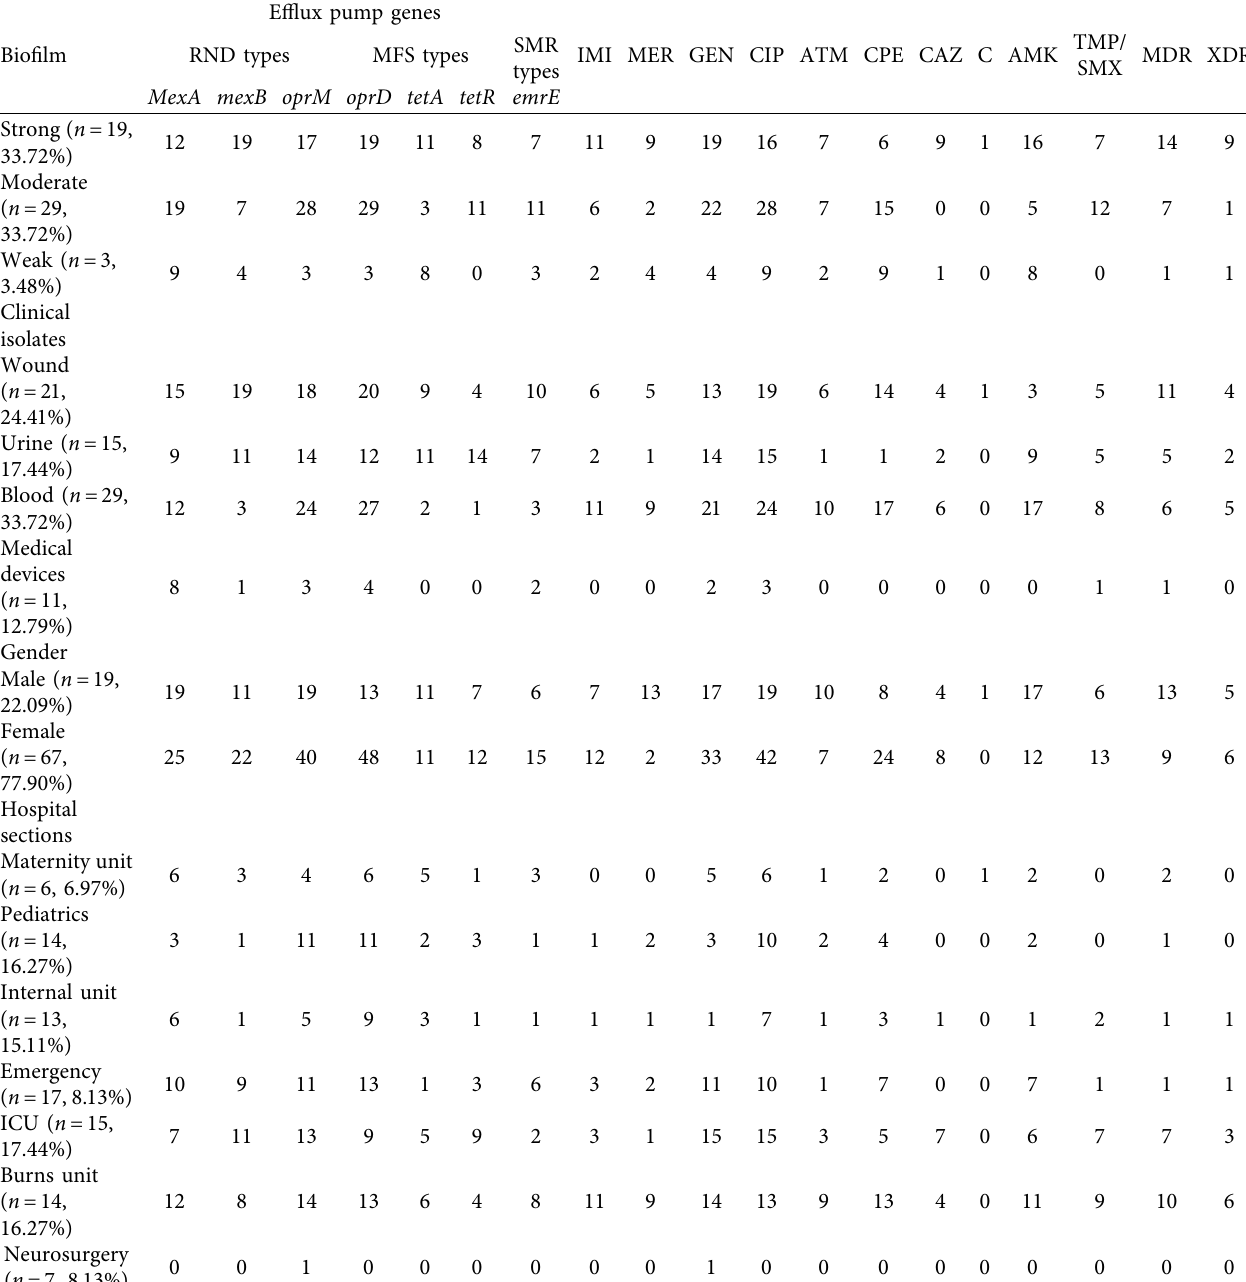
Table 2: The biofilm-forming capacity of P. aeruginosa and percentages of their efflux pump genes related to antibiotics.